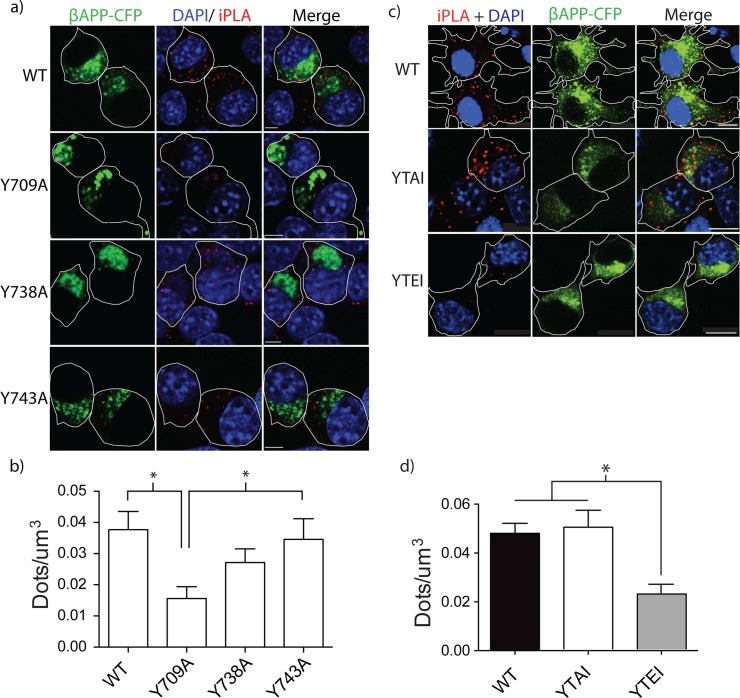
Tyrosine motif mutations affect on APP/AP-3 interaction.SN56 cells were transfected with plasmids expressing wild type APP or APP with mutations Y709A, Y738A, or Y743A. Cells were fixed and iPLA was performed to detect interaction between APP with AP-3δ. a) Representative images are shown. The white border shows edge of the cell and was drawn based on the white light images. Scale bars represent 5μm. b) The dots per cell was counted using Imaris, normalized to cell volume, and graphed in Prism 5.0b (p<0.05). SN56 cells were transfected with plasmids expressing wild type APP or APP bearing phosphomimetic (S711E) or dephosphomimetic (S711A) mutations. Cells were fixed and iPLA was performed to determine if there was an interaction between APP and AP-3. c) Representative images of APP/AP-3δ interaction. The white border shows edge of the cell and was drawn based on the white light images. Scale bars represent 5μm. d) The number of spots per cell was counted and normalized to cell volume. Error bars represent SEM and * = p<0.05.